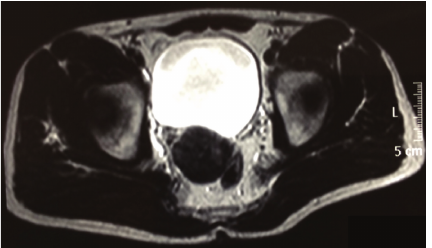
Figure 1: Magnetic resonance imaging T2-weighted imaging showed a mass of 5cm in diameter on the posterior wall of the bladder.